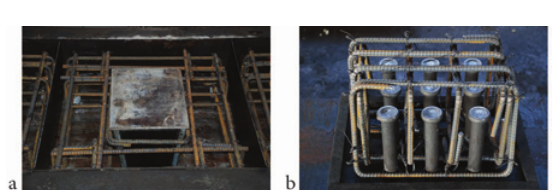
Fig. 3. Push-out specimens